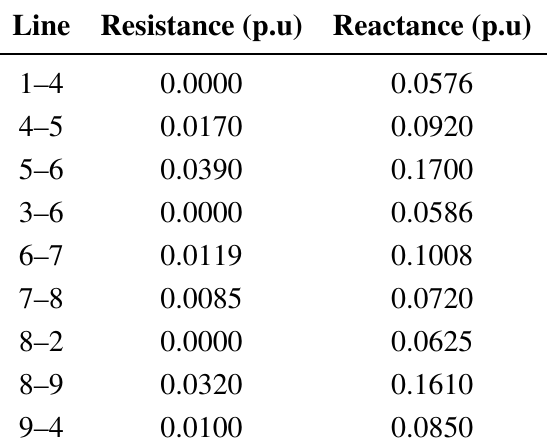
Table 1. Line parameters of the WSCC nine-bus